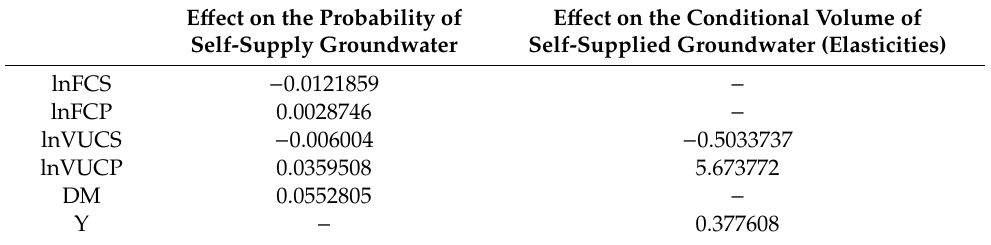
Table 4. Marginal e ff ects on the probability of self-supply and conditional e ff ects of self-supplied groundwater. E ff ect on the Probability of E ff ect on the Conditional Volume of Self-Supply Groundwater Self-Supplied Groundwater (Elasticities) lnFCS − 0.0121859